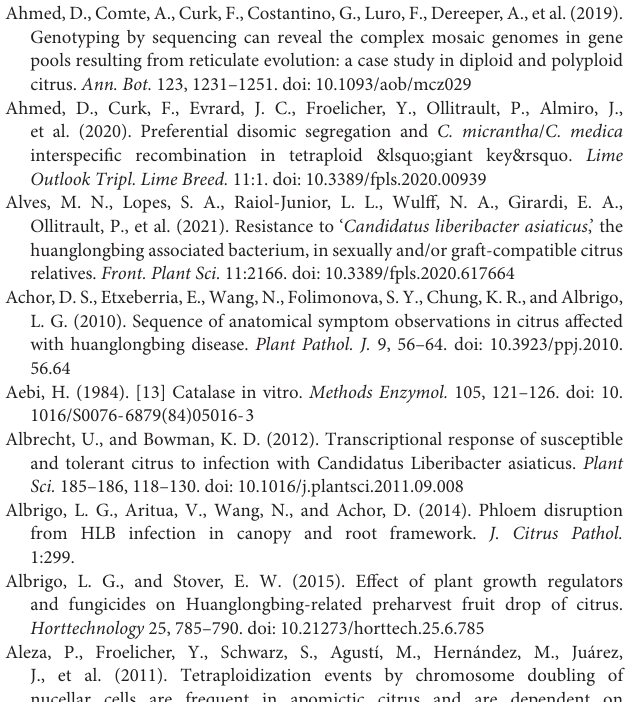
and symptomatic (Las + S; E,F ) from the Mexican and Persian limes, respectively. White arrows indicate the florescence resulting from the presence of Las. Bars = 12 µ